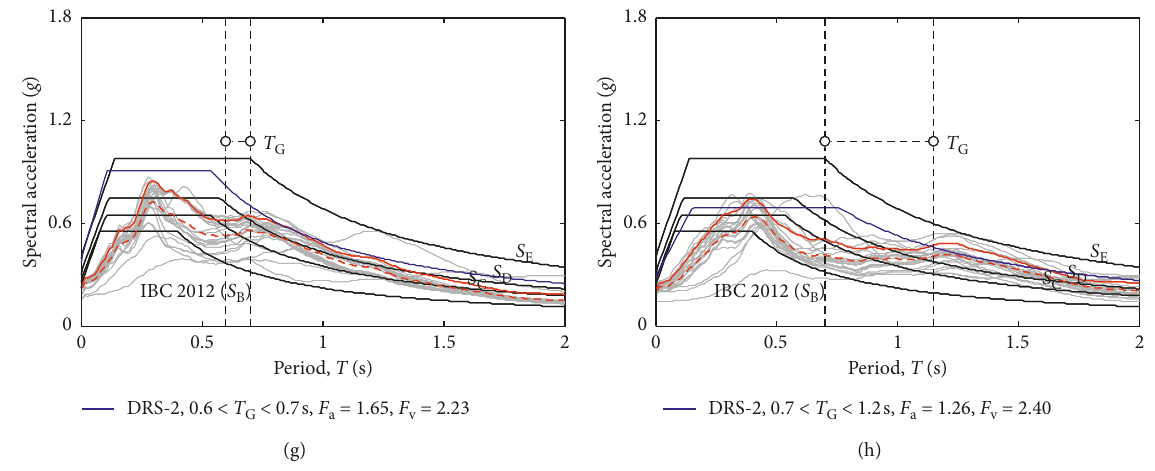
Figure 14: Comparison between numerical analysis results and DRS-2.